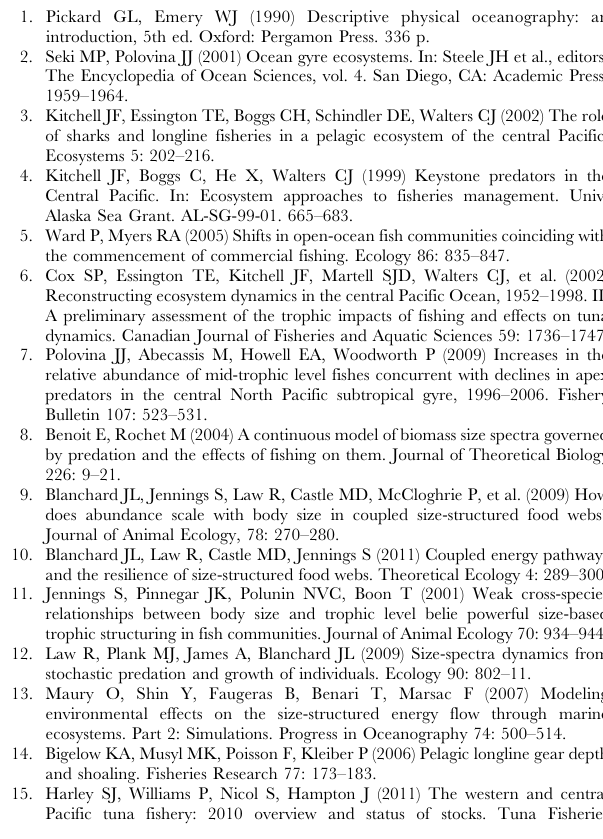
conversion factors. To convert length ( L ) in cm to weight ( W ) in g, the equation aL b = W was used. Table S2 Change in logbook catch rate estimate from statistically significant ( P , 0.01) linear regressions over 1996– 2011, ordered by fish size. From left, columns indicate species, annual percent change in CPUE based on linear regression ( P - values for significant trends in parentheses, insignificant fits denoted by a 0% change), and mean species weight as determined form length-weight